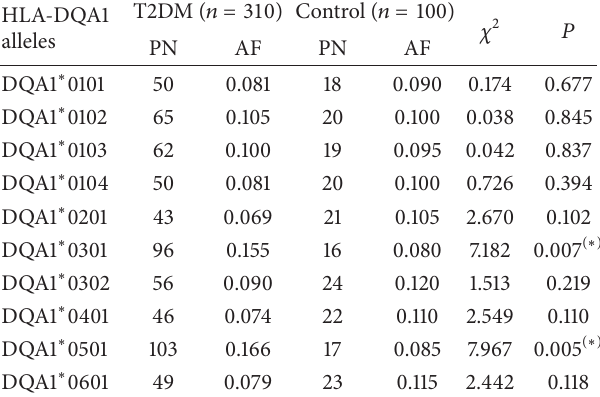
Table 2: Frequency of HLA-DQA1 alleles in T2DM group versus control group.